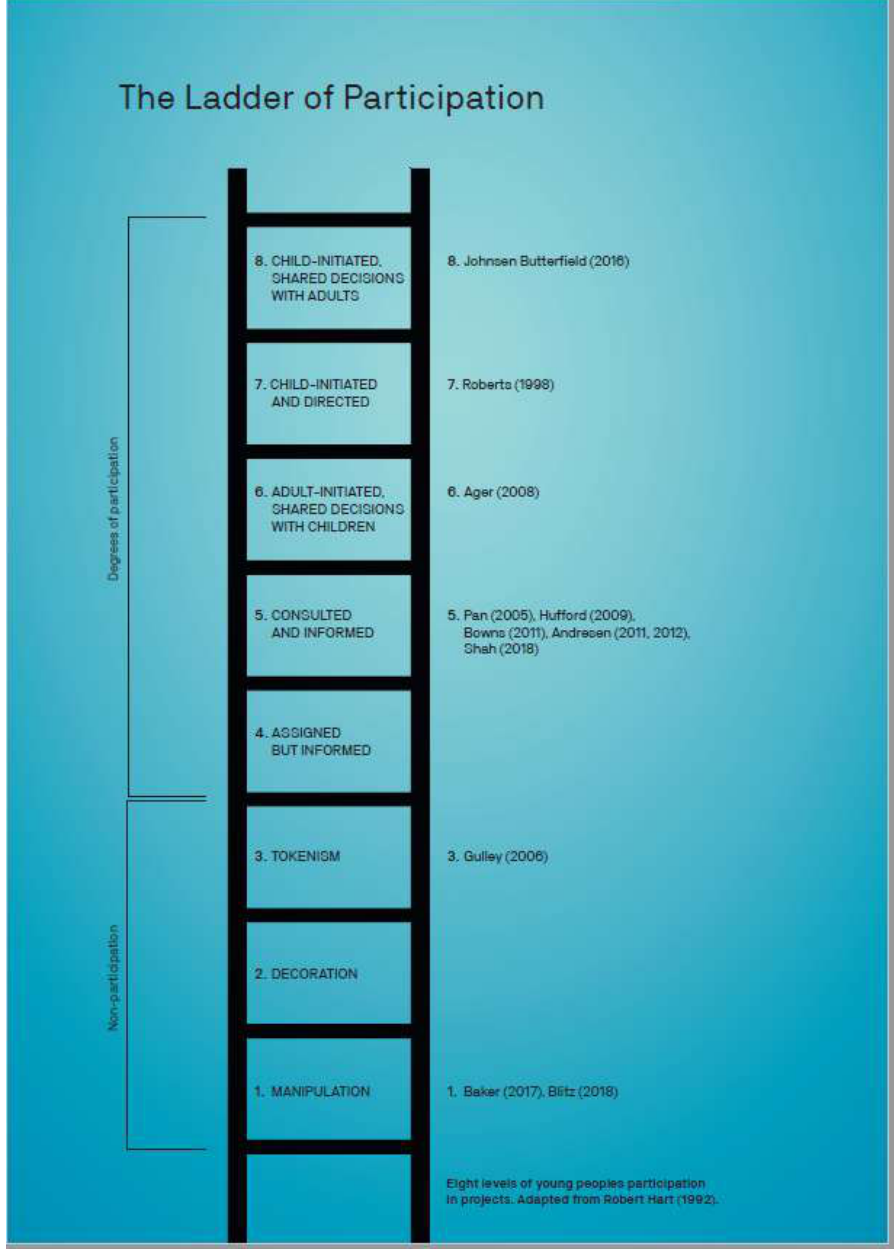
Figure 2. Adherence to ABCD principles and level of participation.